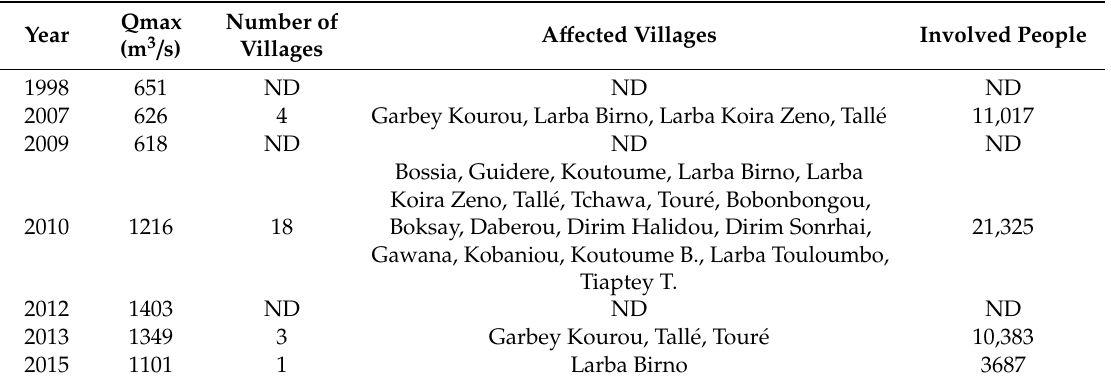
Table 6. Villages a ff ected by year at each flooding events (Q max > 600 m 3 / s), during the period 1998–2015, and the total number of people living in these villages (ND = Not Detected